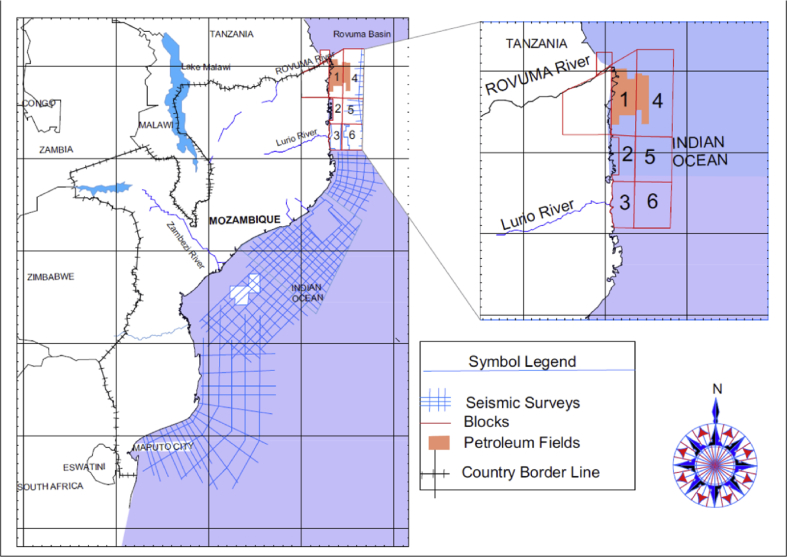
Regional map showing seismic data in Mozambique (Seismic lines from Francis et al., 2017).